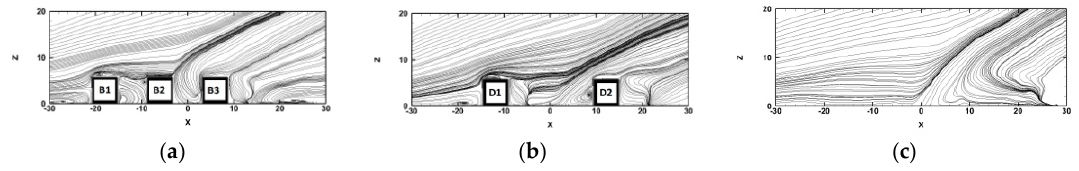
Figure 5. Time-averaged streamlines at the symmetry plane Y = 0 m for ( a ) Case 1; ( b ) Case 2; ( c ) Case 3.